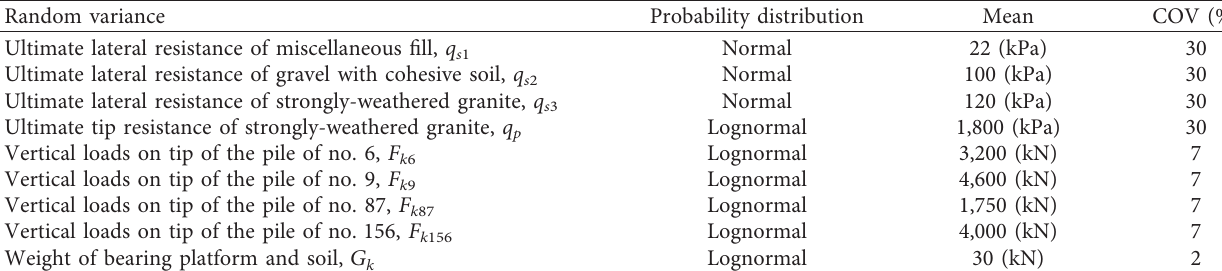
Table 3: Probability model and statistical parameters of basic random variables.